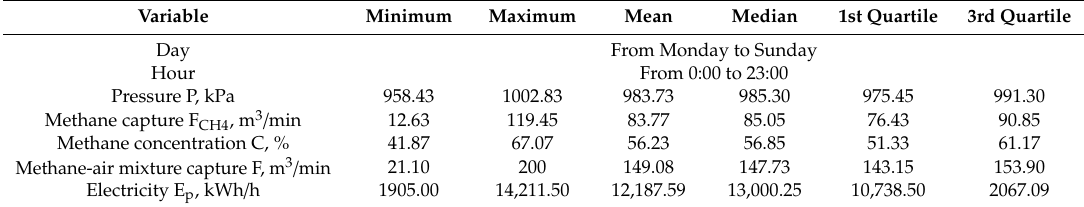
Table 5. Descriptive statistics for input and output